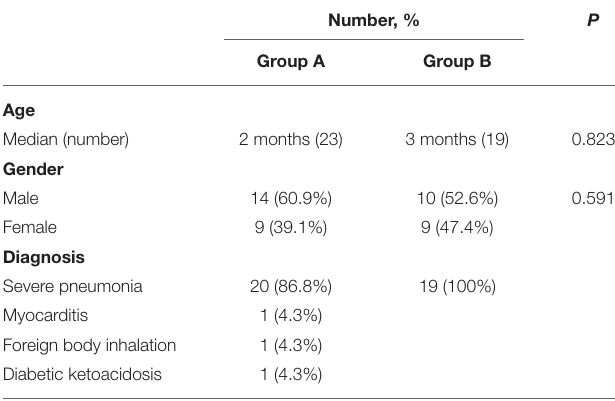
TABLE 1 | Baseline demographics of two